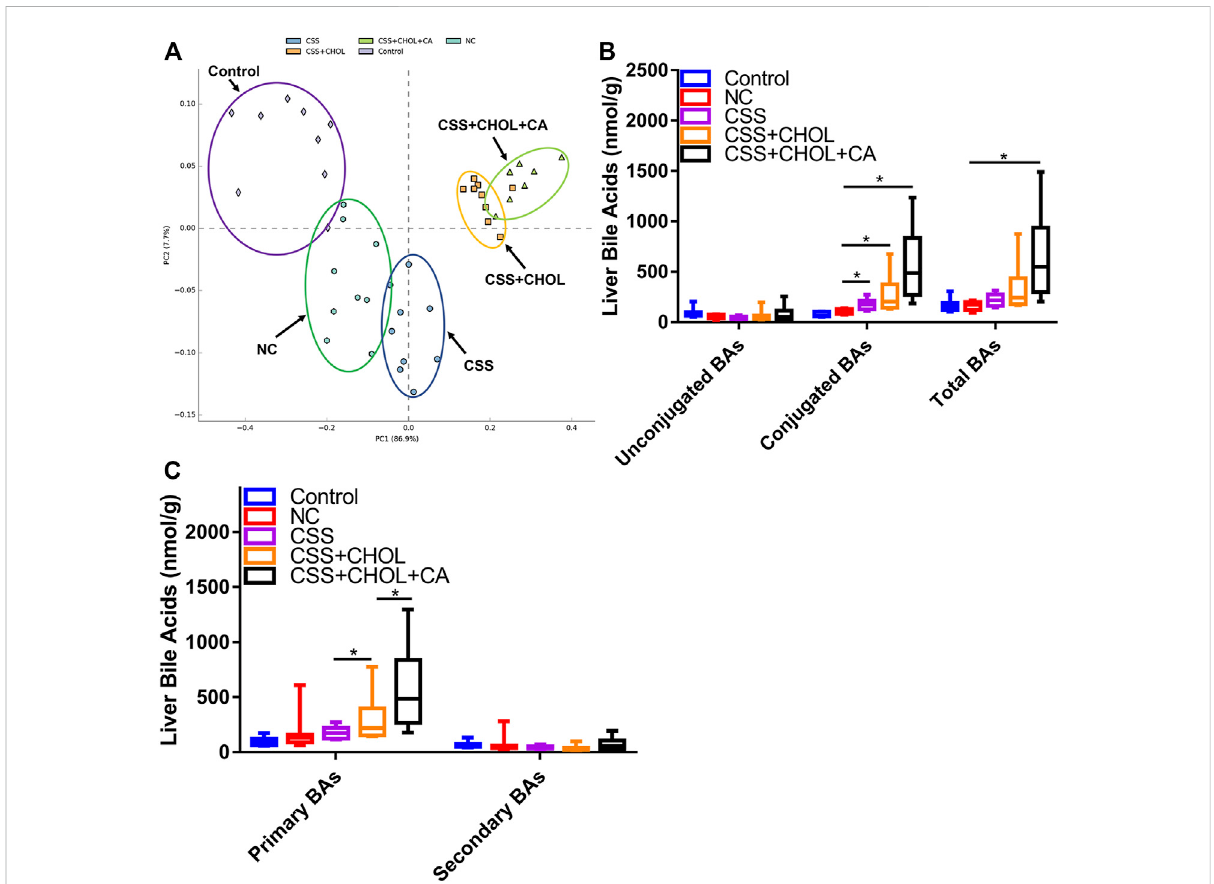
FIGURE 3 Effect of CUMS andCSS on hepatic BA levels. Levelsof 42 distinct BAs weremeasuredin livertissue collected from mice exposed to CUMSand treated with saline (NC), CSS, or CSS along with the BA sequestrant CHOL (with and without CA supplementation). Mice not exposed to CUMS and treated with saline were used as the control group. (A) PCA plot showing different groups based on hepatic BA concentrations. (B) Levels of unconjugated, conjugated, and total BAs in livers collected from different groups. (C) Levels of primary and secondary BAs in livers from different groups. All values are expressed as means ± S.D. An asterisk “ * ” indicates p < 0.05 ( n = 8-9 mice per